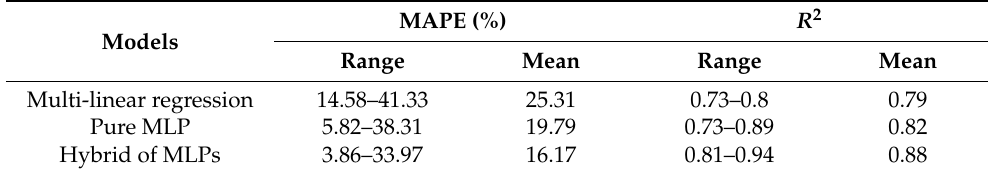
Table 2. Accuracy of high-resolution precipitation maps generated using three models. MAPE Models